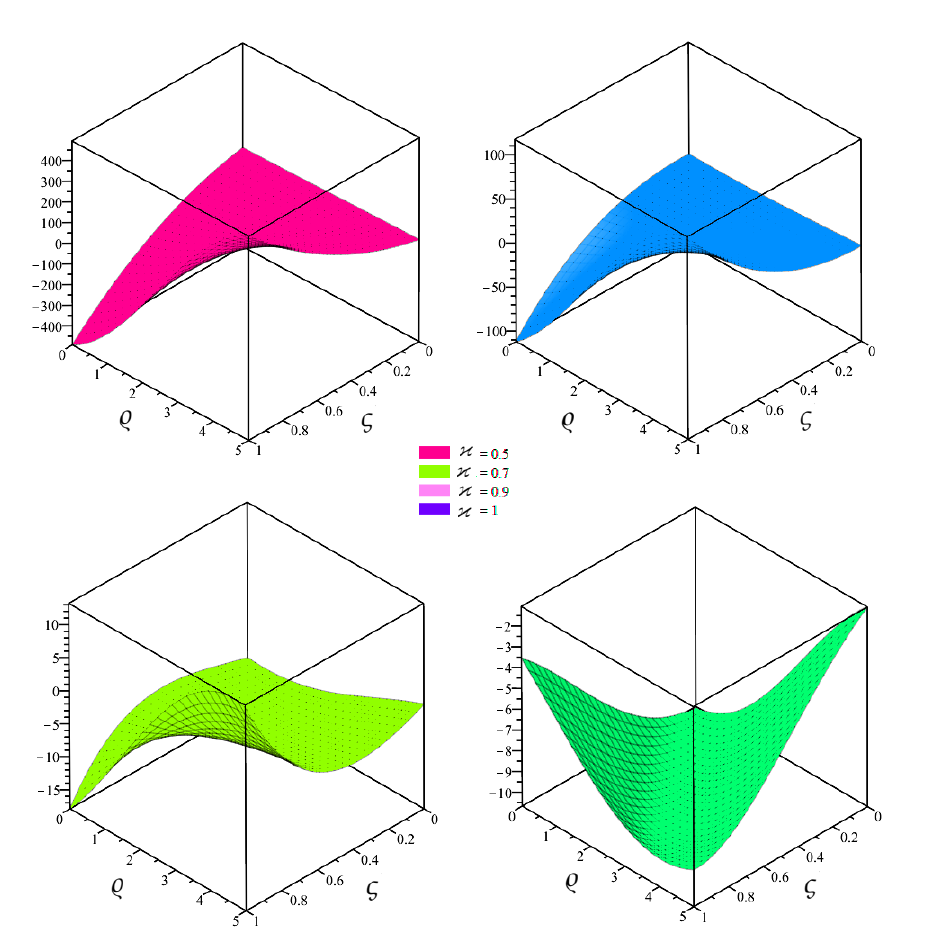
Figure 4. The analytical solutions of different fractional order κ of Problem